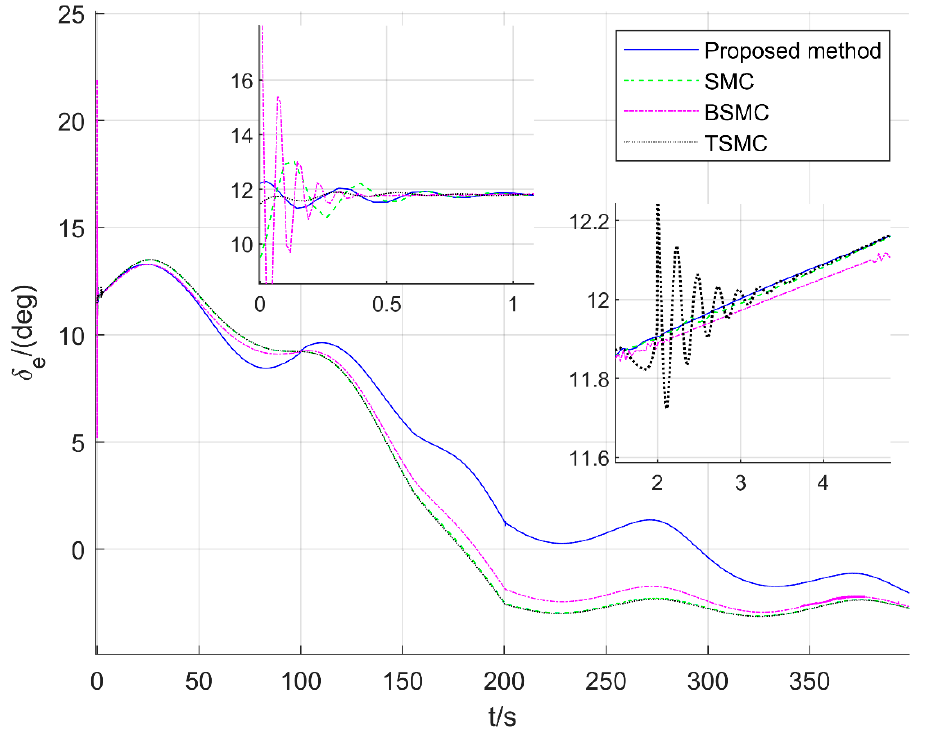
Figure 14. Responses of elevator deflection.